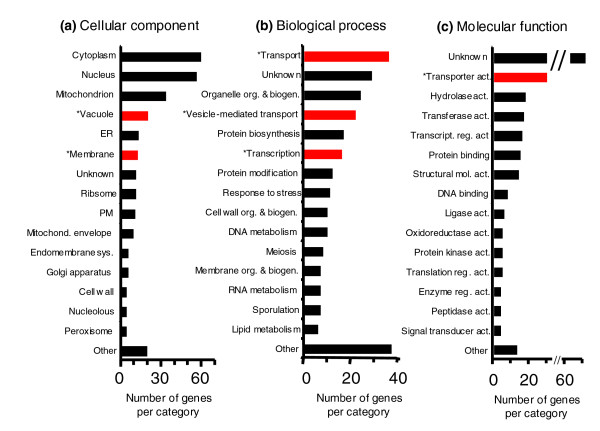
All cellular compartments are involved in the maintenance of poly P levels. Categorization of the 255 genes important for poly P levels by using the GO Slim terminology to: (a) cellular component, (b) a biological process and (c) a molecular function. Categories that were significantly overrepresented (P ≤ 0.05; red bars) are marked by an asterisk. Only the 15 most abundant categories are shown (all other genes are summarized as 'other').